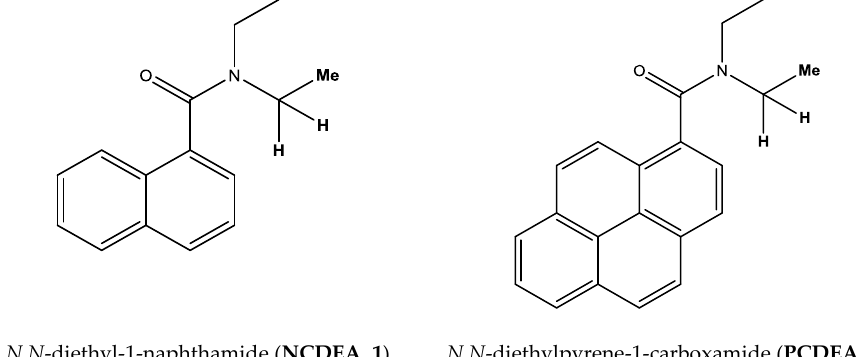
Figure 1. Structures of N , N -diethylamide